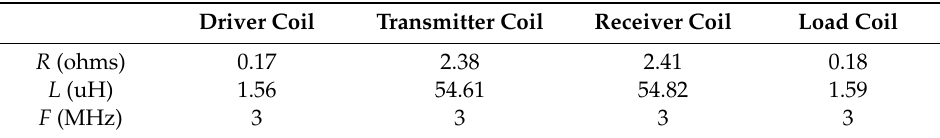
Table 2. Electrical parameters of the coils.